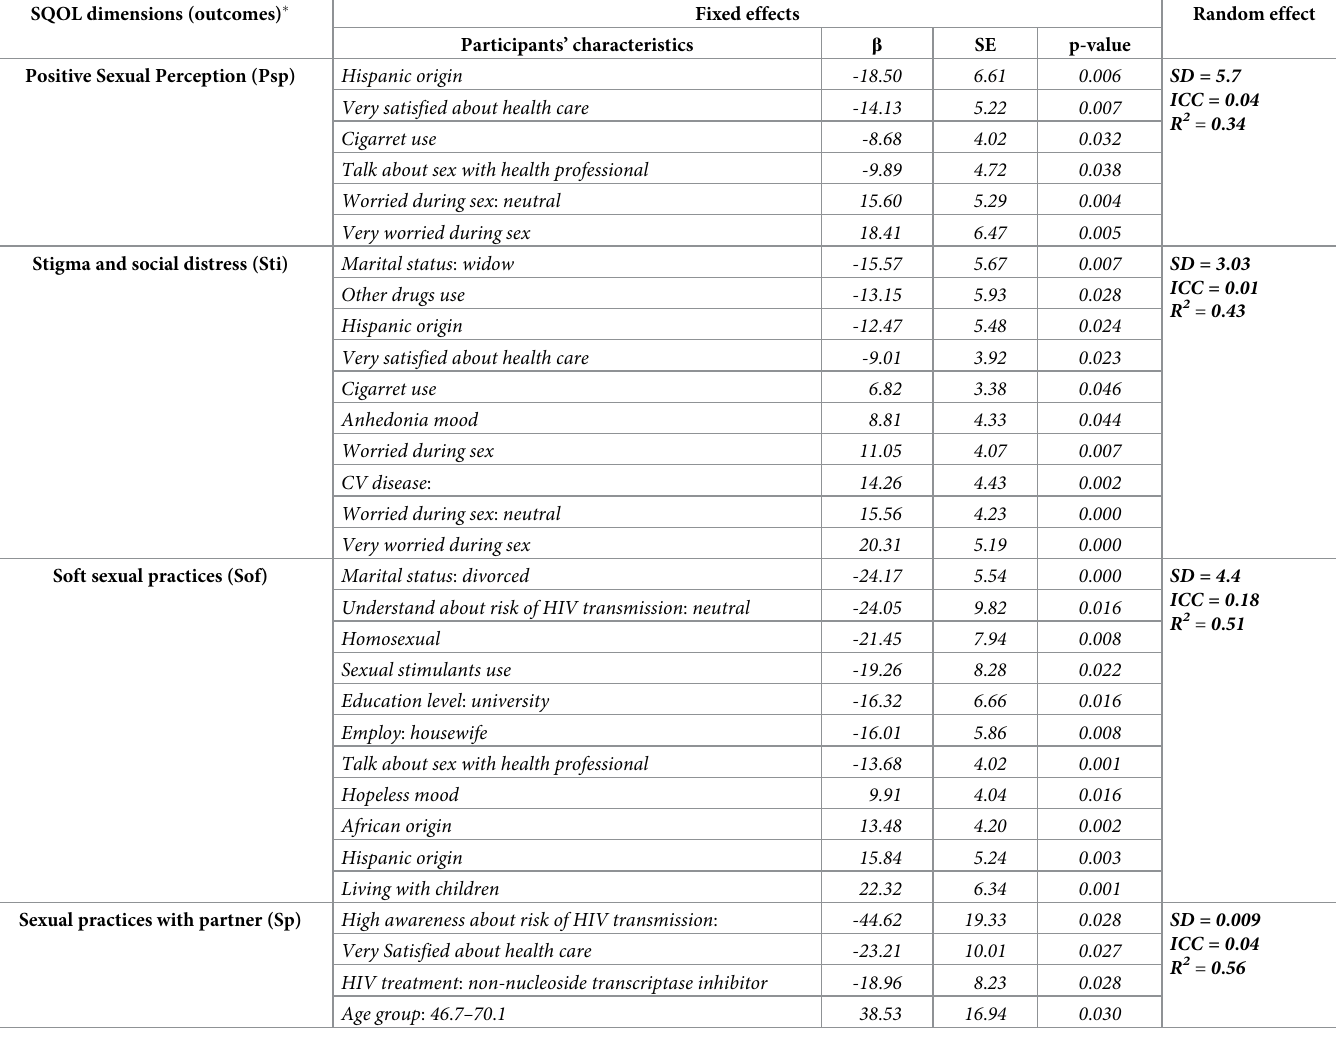
Table 3. Factors associated with PROQOL-Sex Life dimensions among WHIV (multivariable linear mixed effects regression). SQOL dimensions (outcomes)